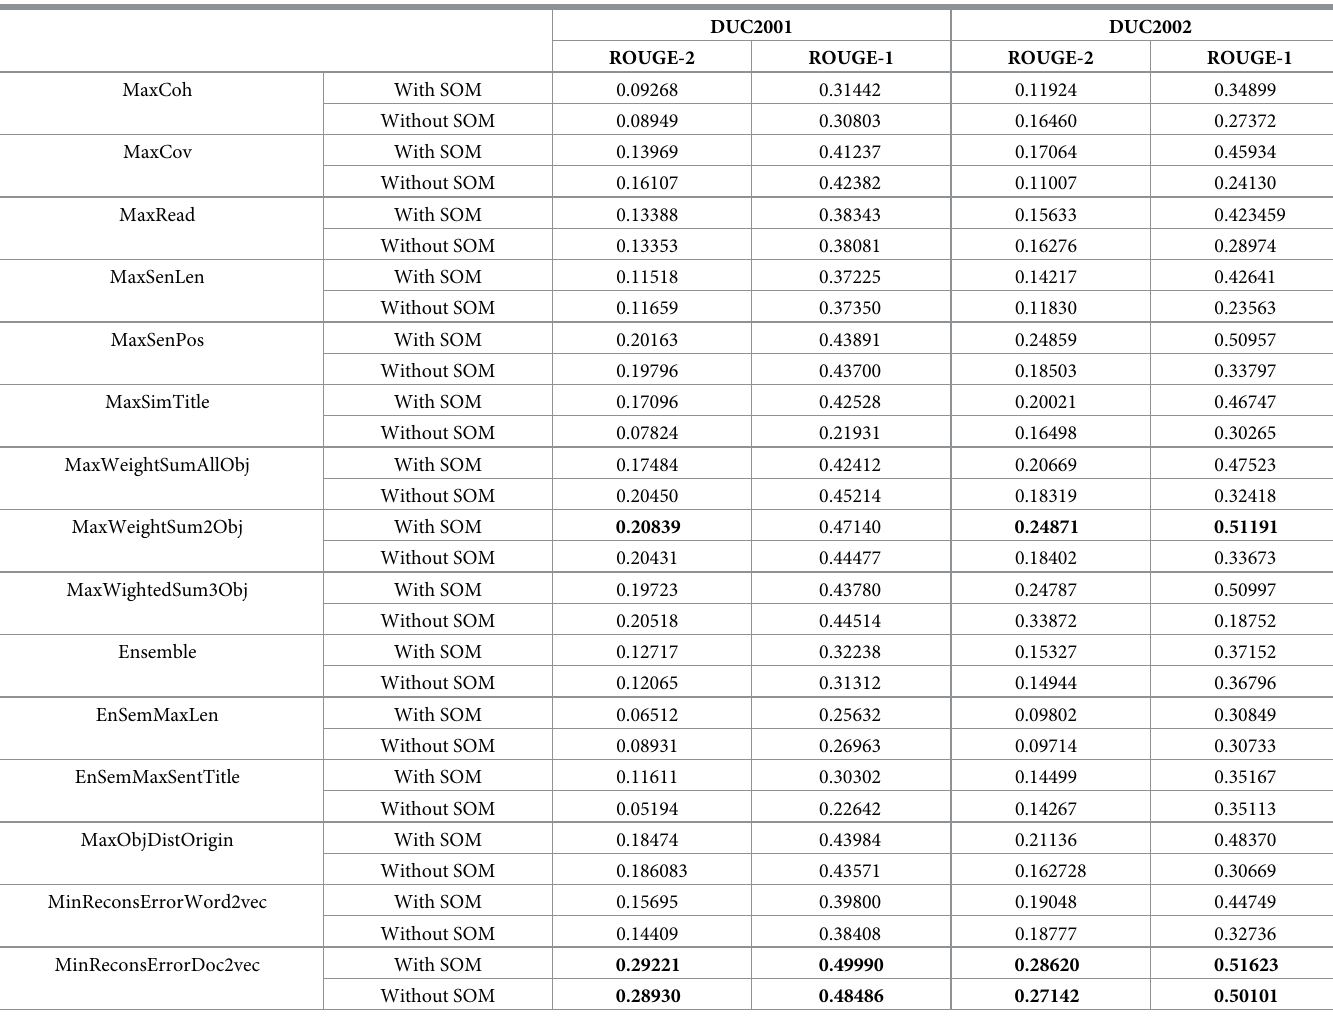
Table 6. ROUGE scores obtained using Approach-1 (WMD) when the best solution is selected using any of the strategies under UMaxRouge strategy. All the strate- gies explored here for selecting a single best solution from the final Pareto front are unsupervised in nature. Bold entries indicate they are able to beat the state-of-the-art